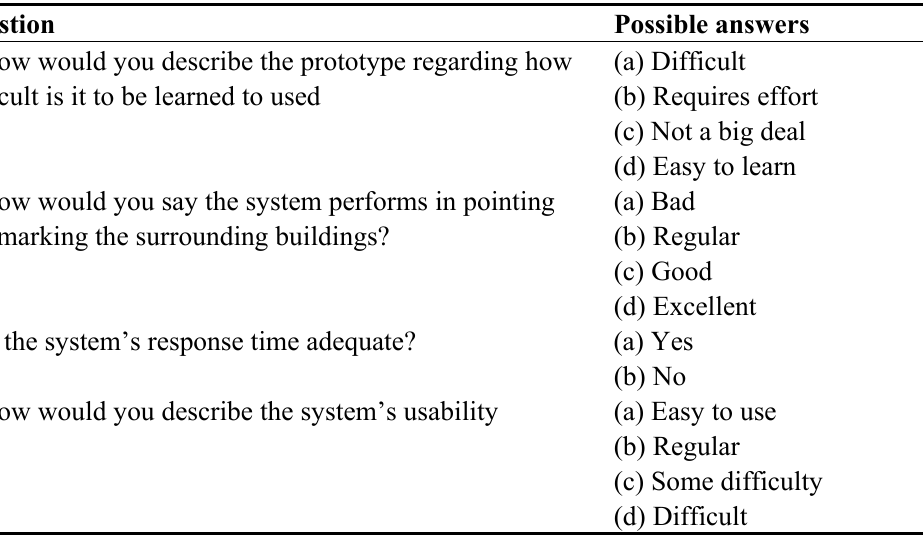
Table 1. Prototype qualitative